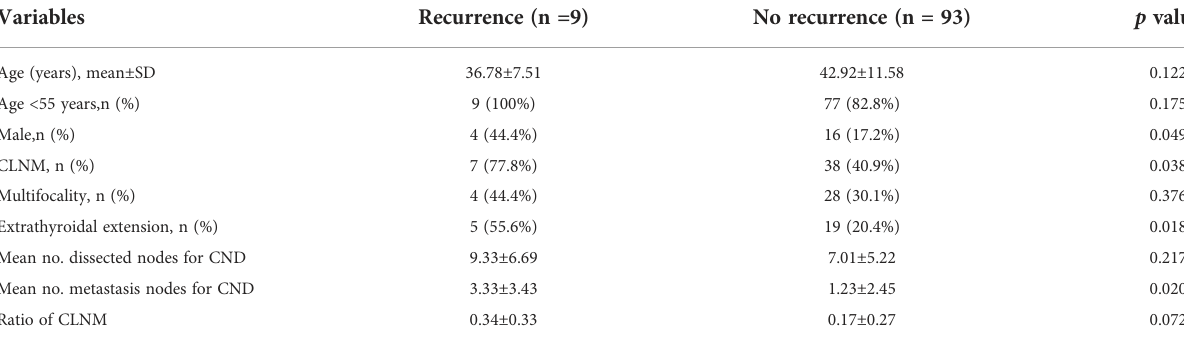
TABLE 4 Clinicopathologic factors related to tumor